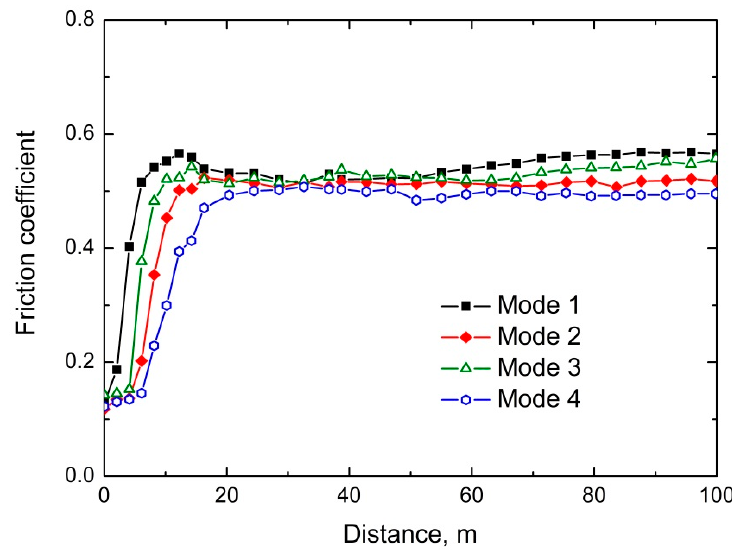
Figure 6. Friction coefficient of the Ti-Al-Ta-N coatings obtained in different sputtering modes as a function of sliding distance.